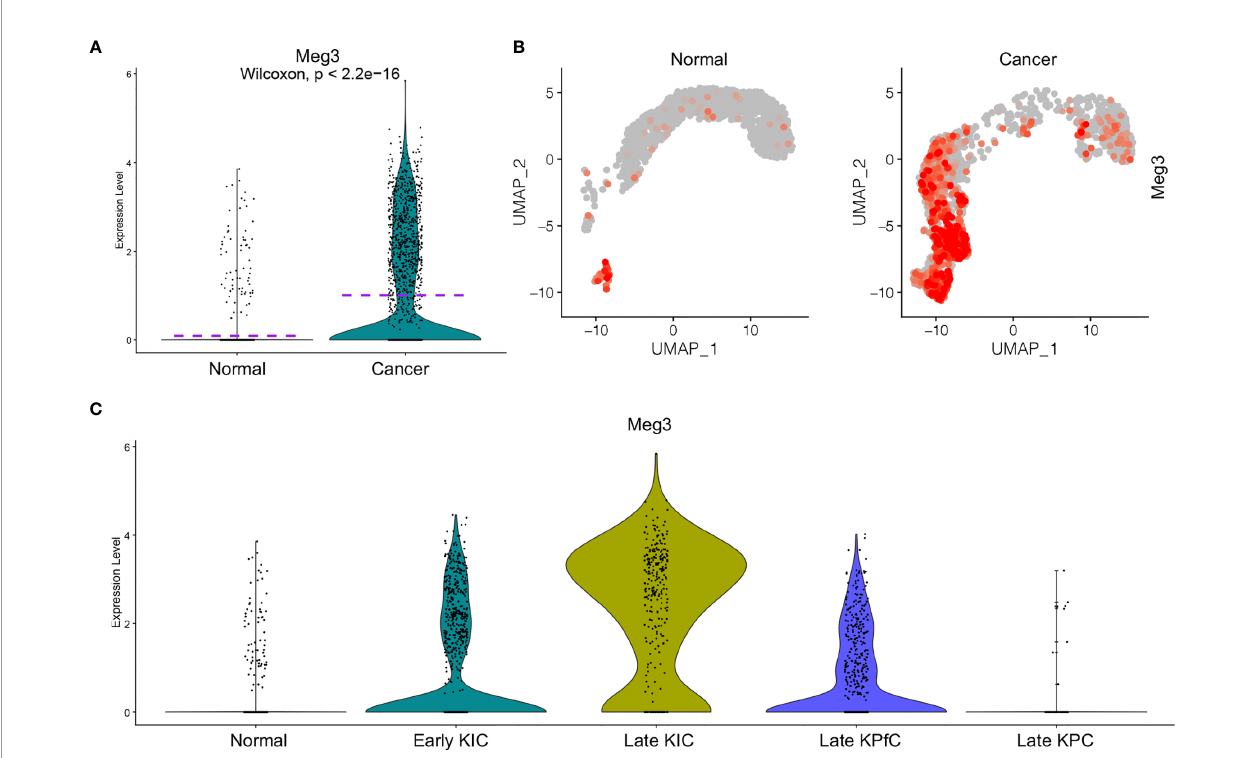
FIGURE 6 | Elevated MEG3 transcript in cancer cells of PDAC mouse models (33). Transcript levels of MEG3 in normal epithelial cells and PDAC cancer cells of mouse models were visualized by split violin plots (A) and UMAPs (B) . (C) Upregulated MEG3 expression in cancer cells of PDAC mouse models including early KIC, late KIC and late KPfC compared to normal epithelial cells. Rare MEG3 was detected in late KPC due to extremely low cell